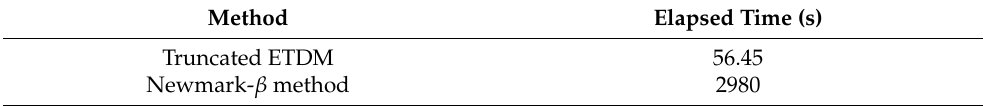
Table 1. Computation time for different methods. ETDM: explicit time-domain